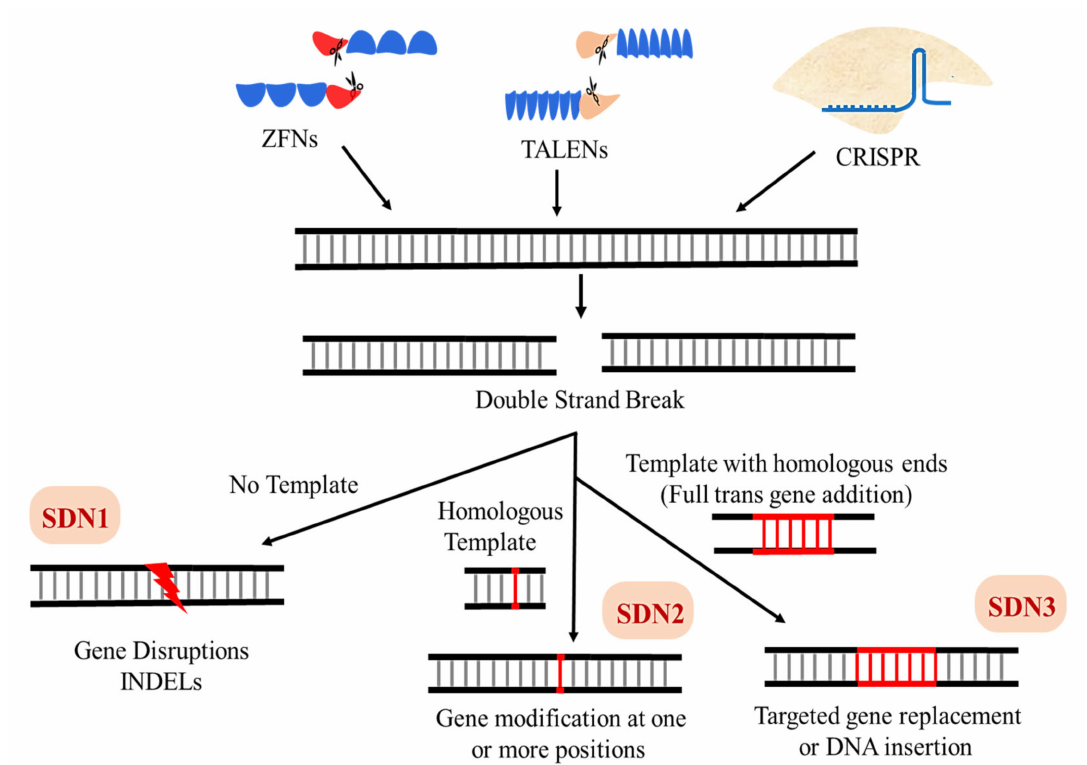
Figure 8. Schematic diagram of SDN1, SDN2, and SDN3. Nucleases such as ZFNs, TALENs, and CRISPR/Cas9 bind with target DNA to cause DSBs that are repaired by two different mechanisms. SDN1 does not need a template and results in gene disruptions through indels (small insertions or deletions of bases). SDN2 utilizes a homologous template and results in gene correction or modification at one or more positions. SDN3 requires a full gene as a template, and leads to gene replacement or foreign DNA